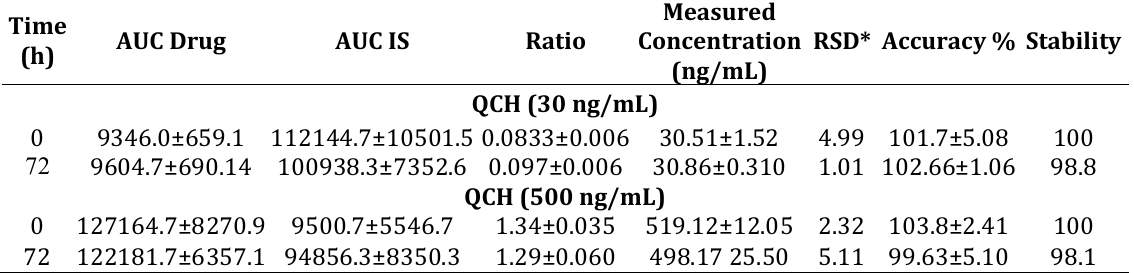
Table V. Montelukast QC samples freeze and thaw stability. QCL (30 ng/ml) and QCH (500 ng/ml). Time